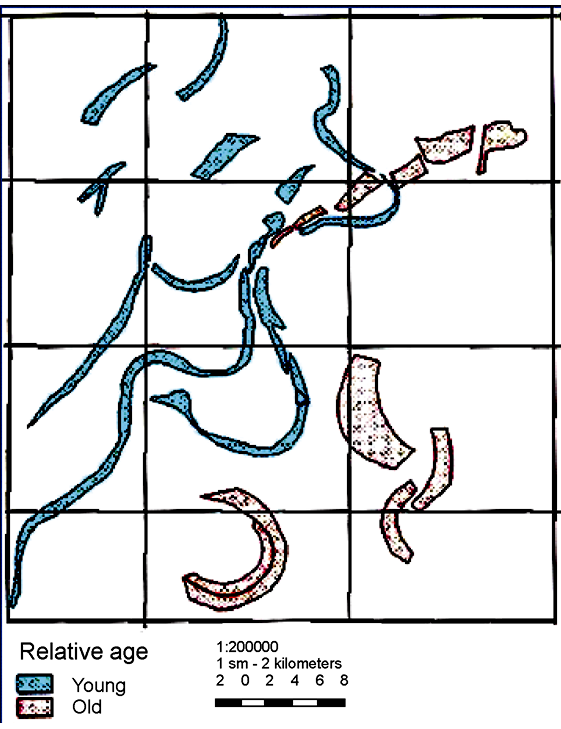
Figure 3. Scheme of buried paleovalleys Figure 4. Geological map ( a ), cosmic structure scheme